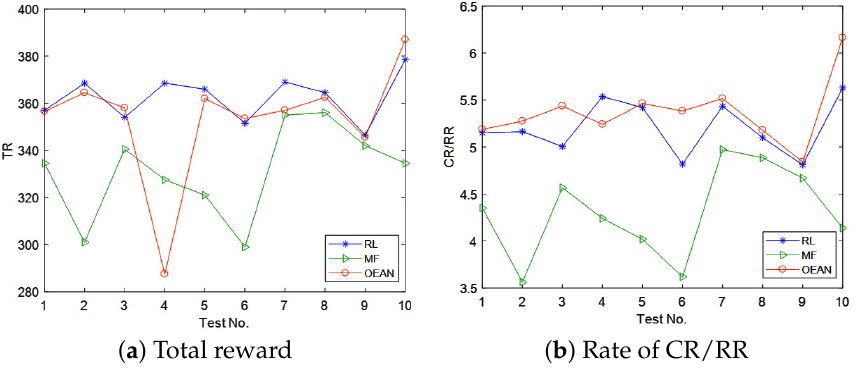
Figure 5. Tests result with the random location of the rock particles in the coal layer. ( a ) is the total reward of the three methods. ( b ) is the rate of CR to RR.